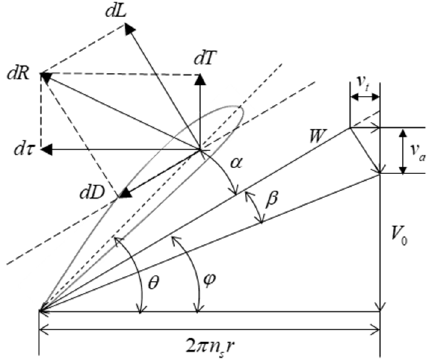
Figure 2. The velocity and force acting on the blade element.